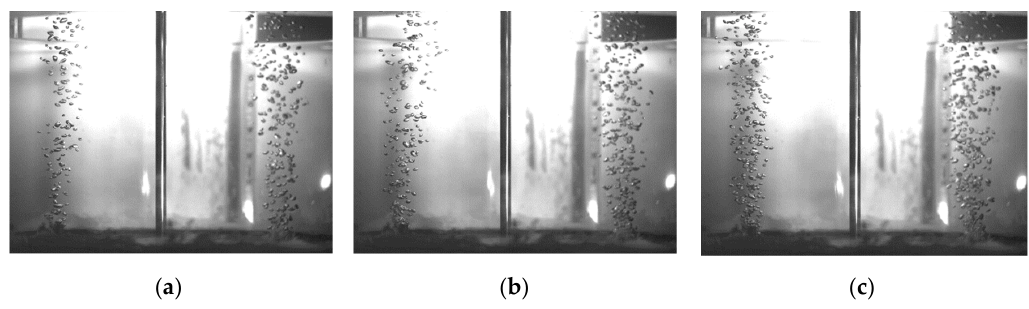
Figure 2. Gas injection using two porous plugs in the physical modelling: ( a ) 0.98 L·min − 1 ; ( b ) 1.30 L·min − 1 ; and ( c ) 1.63 L·min − 1 .